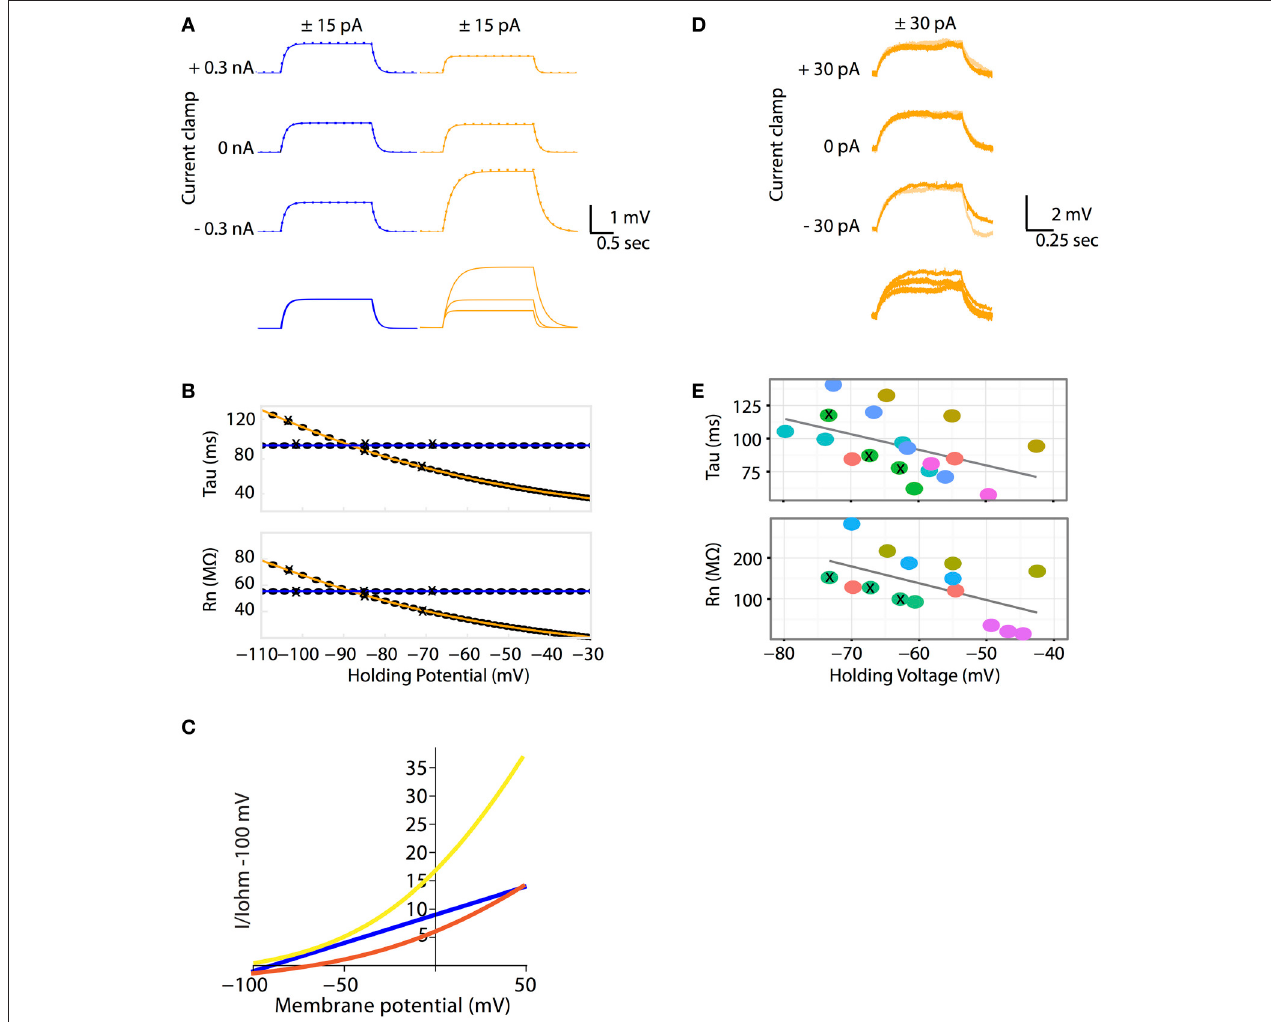
FIGURE 2 | (A–C) The Goldman-Hodgkin-Katz leak-current model predicts non-linear voltage responses to DC current injections. (A) All Ohmic model simulations are colored in blue and all GHK model simulations are colored in orange. Voltage traces of passive membrane responses to + 15 pA (solid lines) and − 15 pA (inversed and superimposed, dotted lines) current injections for 2 seconds, at − 0.3, 0 and + 0.3 nA holding currents. Bottom traces: voltage responses to + 15 pA current pulse at various holding currents superimposed. The Ohmic and GHK cell models have identical surface areas, E rest ( − 85mV) and membrane resistances (120 kohm cm 2